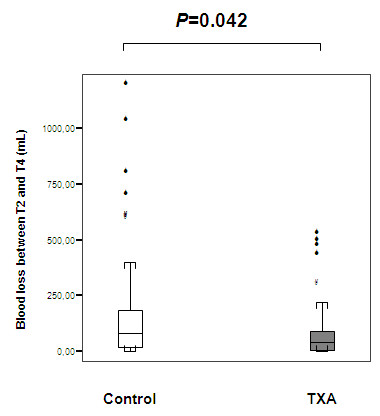
Graph illustrating blood loss between T2 and T4 between the two groups. P = 0.04 using the Mann-Whitney U test after applying the Bonferroni correction.